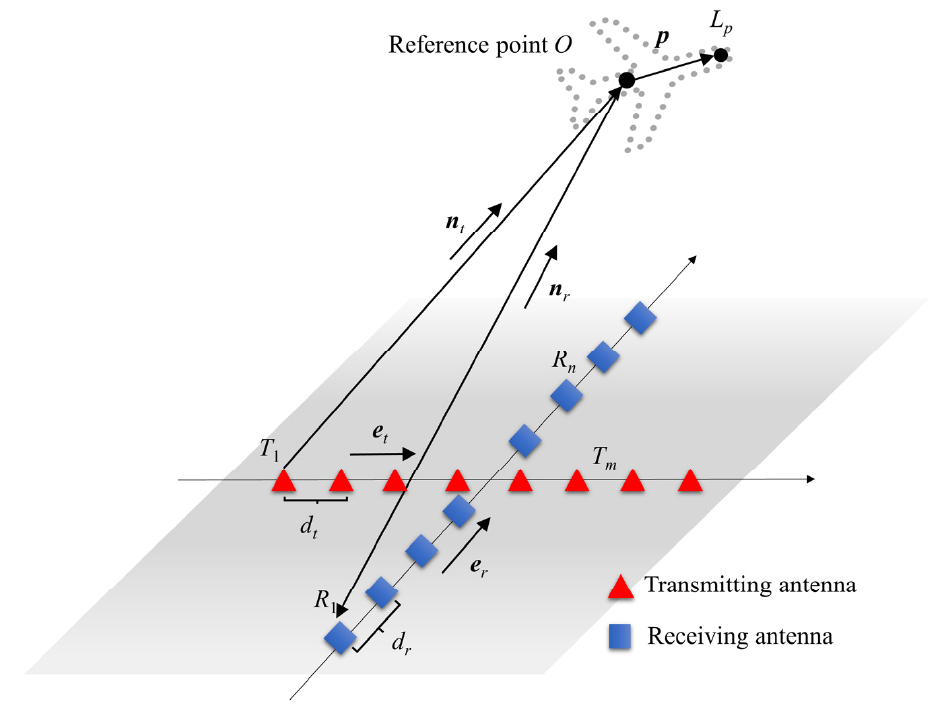
Figure 1. MIMO radar target 3D imaging geometry.